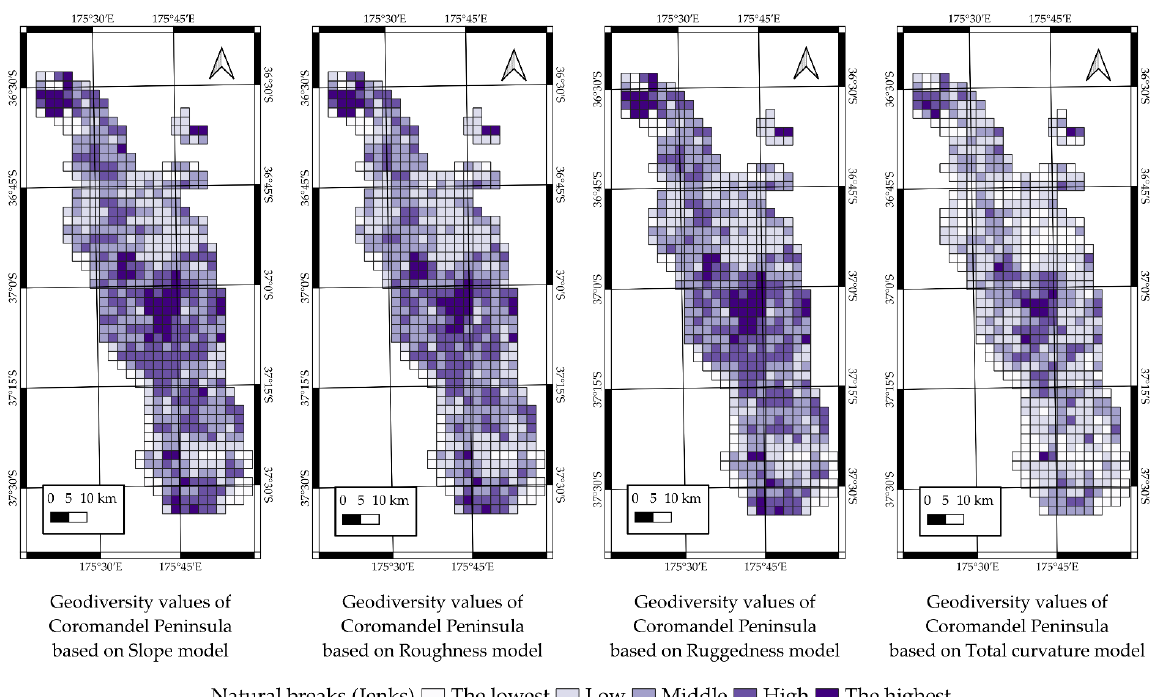
Figure 4. Geodiversity values of Coromandel Peninsula for geosite recognition, based on numerical geomorphological models: slope, roughness, ruggedness, and total curvature. Natural breaks (Jenks) mode of evaluation.